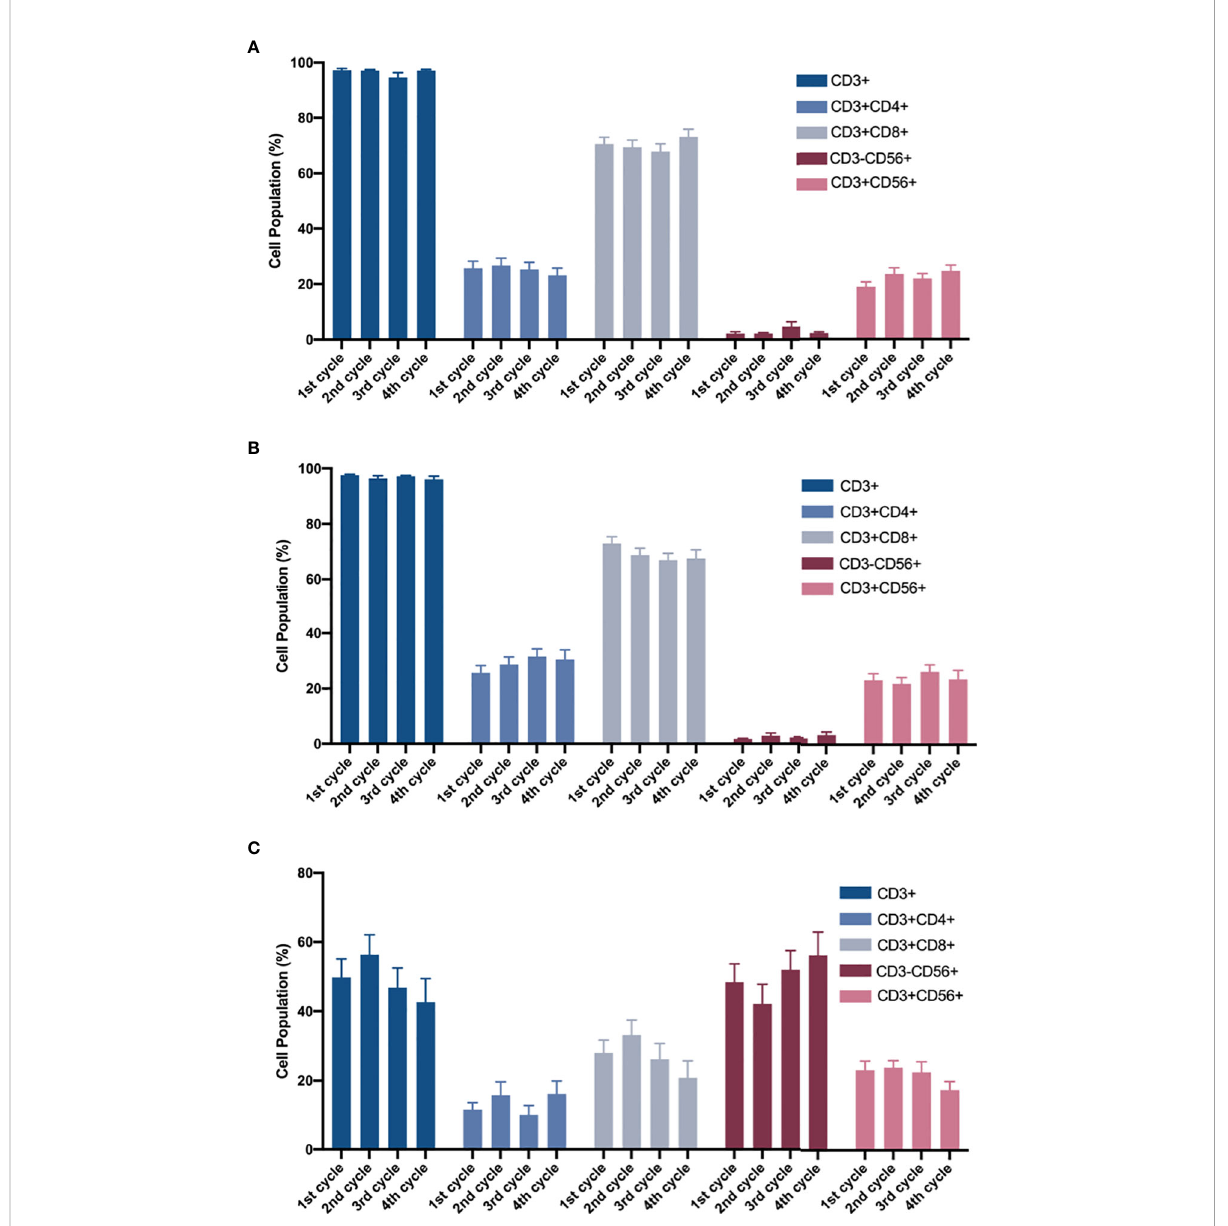
FIGURE 3 After 14-day of ampli fi cation, the proportions of different cell populations in the four cycles. (A) CIK group and (B, C) CIK + NK group were analyzed by two-way ANOVA. The cell population of the phenotypes in (A) CIK group, CIK + NK group during (B) CIK culture and (C) NK culture has been shown. For the same cell population, neither CIK group nor CIK+NK group, was no statistical difference between any two cycles. The results are represented as mean ±